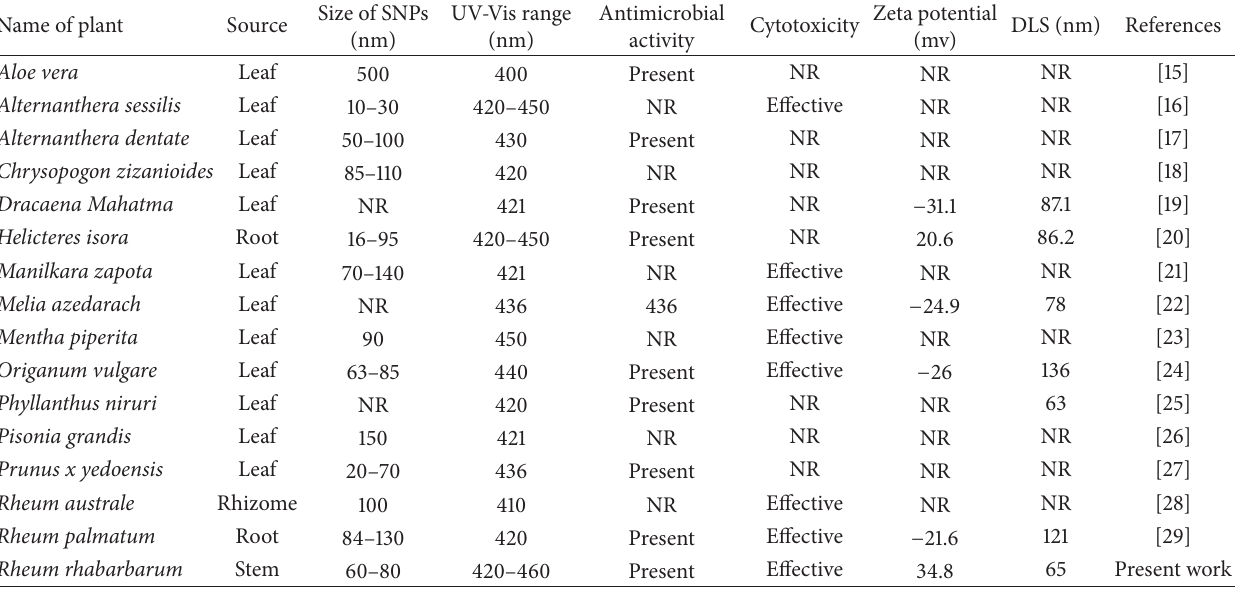
Table 1: Partial list of comparative parameters reported for plant based SNPs in the